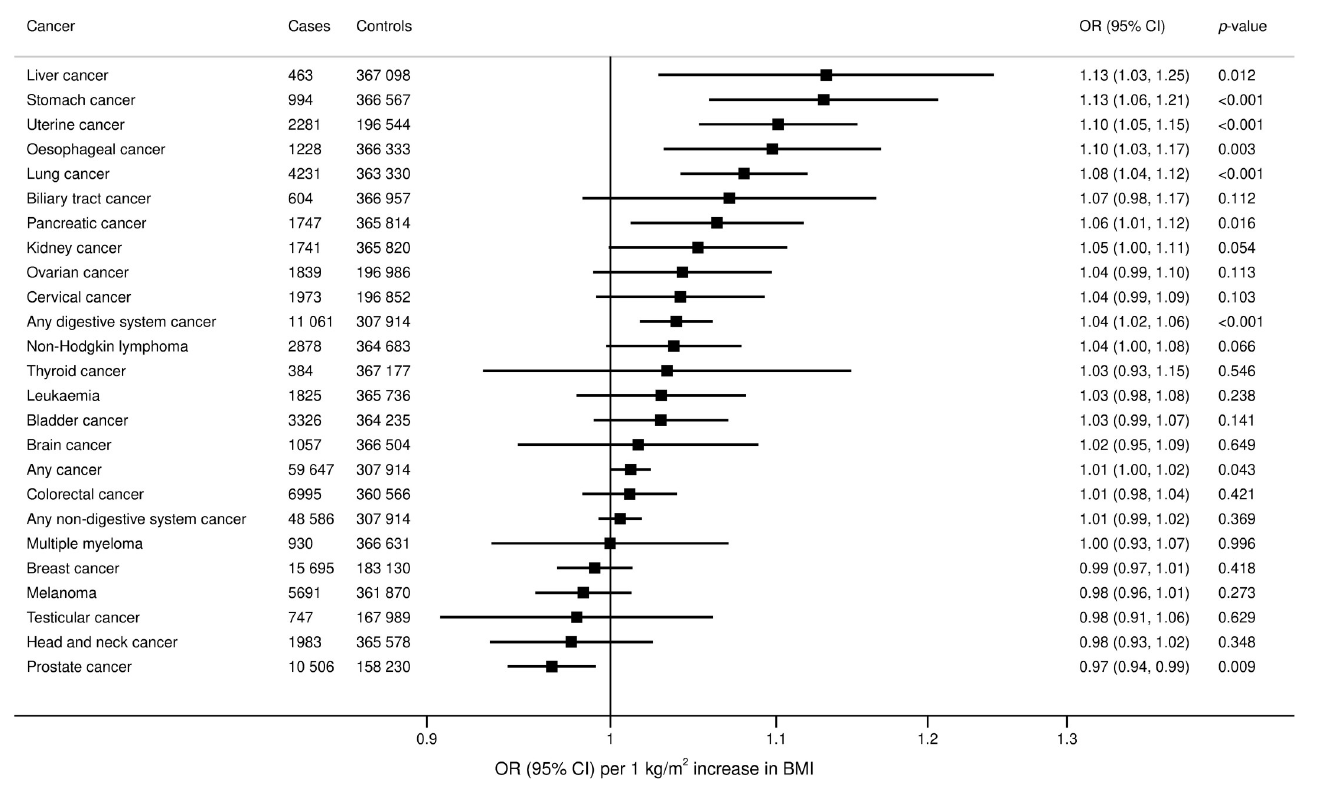
Fig 1. Associations of genetically predicted BMI with overall and site-specific cancers in the UKBB. ORs are expressed per 1 kg/m 2 increase in BMI. Results are obtained from the random-effects inverse-variance weighted method. B AU : AbbreviationlistsofFigs 1 (cid:0) 6 havebeenupdated : Pleaseverifythatallentriesarecorrect : MI, body mass index; CI, confidence interval; OR, odds ratio; UKBB, UK Biobank.